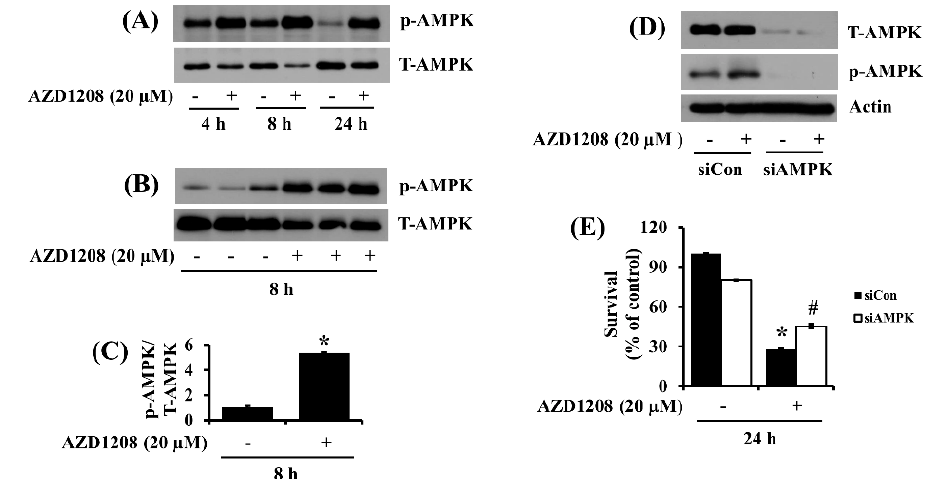
Figure 5. Effect of AZD1208 and/or knock-down of AMPK on survival of 93T449 cells and cellular expression and phosphorylation of AMPK. ( A ) 93T449 cells were treated with AZD1208 (20 µM) or vehicle control (DMSO) for the times designated. At each time point, whole cell lysates were prepared and analyzed for p-AMPK and T-AMPK by Western blotting. p-AMPK, phosphorylated AMPK; T-AMPK, total AMPK. ( B ) Western blotting in triplicate experiments for 8 h. ( C ) The densitometry data of ( B ). * p < 0.05 compared to the control at the indicated time. ( D ) 93T449 cells were transfected with 100 pM of control siRNA (siCon) or AMPK siRNA (siAMPK) for 24 h. The siCon- or siAMPK-transfected cells were treated with AZD1208 (20 µM) or vehicle control for 24 h. Whole cell lysates were prepared and analyzed for p-AMPK, T-AMPK or β -actin by Western blotting. ( E ) 93T449 cells were transfected with 100 pM of control siRNA (siCon) or AMPK siRNA (siAMPK) for 24 h. The siCon- or siAMPK-transfected cells were treated with AZD1208 (20 µM) or vehicle control for 24 h, followed measurement of the number of surviving cells by cell count assay. The cell count assay was performed in triplicate. Data are means ± SE of three independent experiments. * p < 0.05 compared to the control at the indicated time; # p < 0.05 compared to AZD1208 at the indicated time.